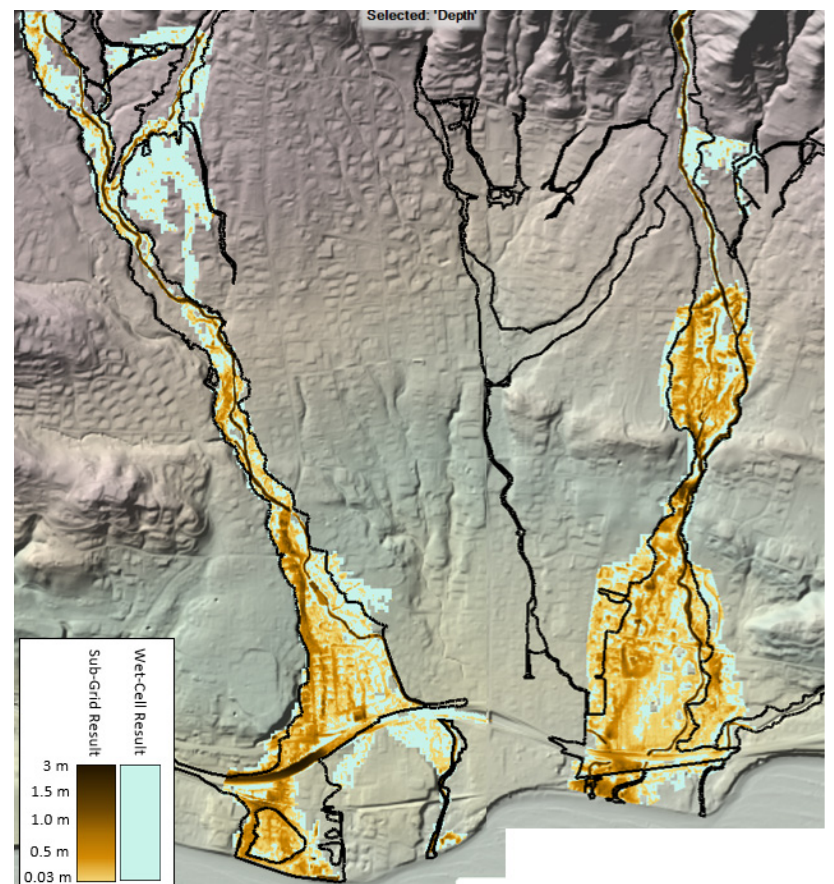
Figure 10. The sub-grid mudplain maps (brown) from Figure 2 plotted with the “wet cell” maps (blue) from the same simulation. Wet cell maps are more conservative and may be more appropriate for emergency management actions.